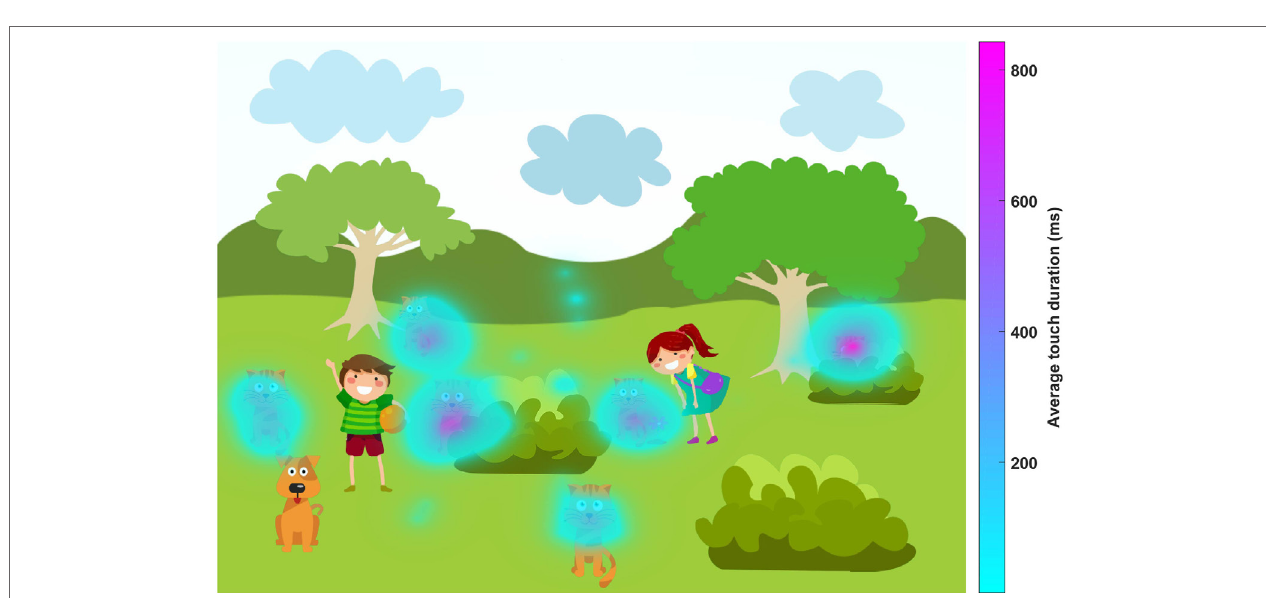
FigUre 5 | Average time spent touching the different areas of the picture, showing the focus of children’s attention on the target of the scene (cat character). Note that the targets from all six levels are shown here, while a child only sees one target in each